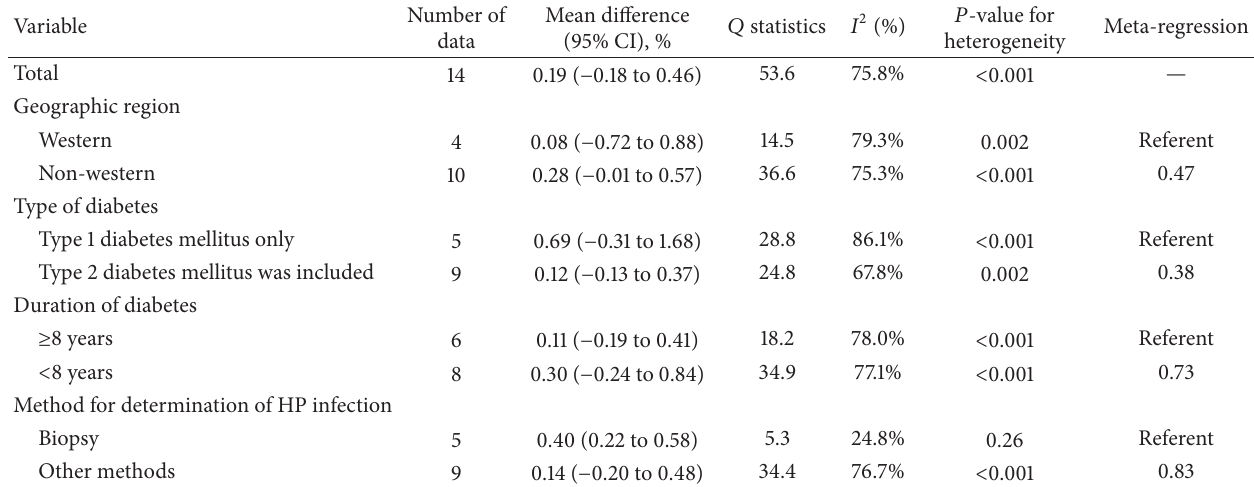
Table 3: Stratified analyses of differences between those with Helicobacter pylori (HP) infection versus those without HP infection in hemoglobin A1C level with 95% confidence interval according to key study